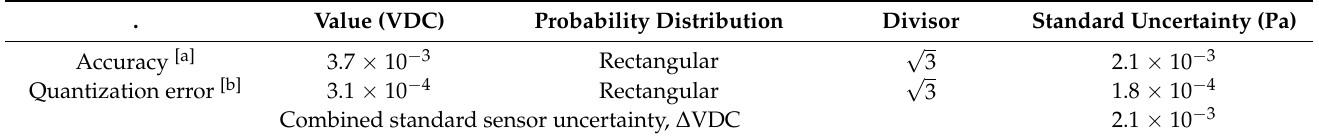
Table 5. Uncertainty budget analog voltage measurement by DAQC board for RTD measurement. .